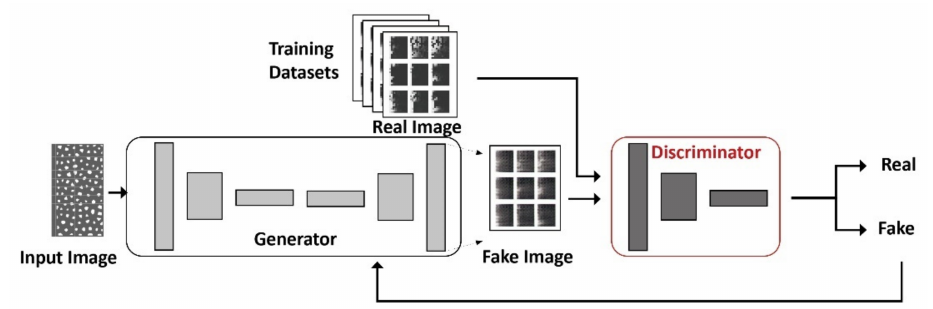
Figure 14. The implementation of a generative adversarial network (GAN) deep learning model. Validation of model accuracy was performed by comparing all predicted DA graphics and TA visualizations to the simulation results. After converting the visualizations to grayscale images, the RGB values of each pixel were compared. The mean absolute error (MAE) was used to test the accuracy of the machine learning prediction by comparing the absolute difference between the simulation results and predicted results (Equation (3)) [48]. 99% (Table 2).